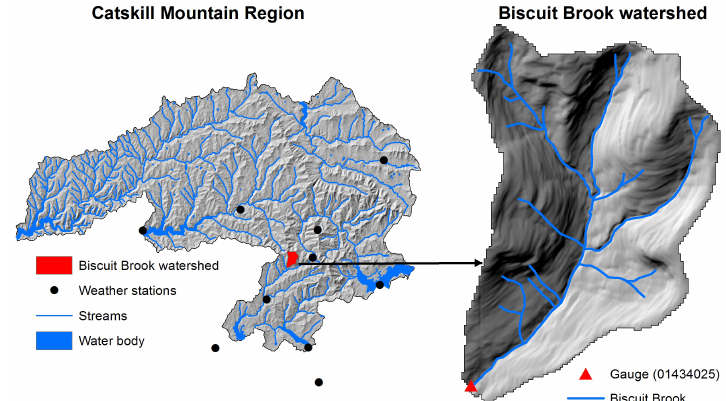
Fig. 1. The location of the Biscuit Brook watershed (red area) and the United States Geological Survey gauge station within the Catskill Mountain region of New York State. The map on the left depicts boundaries of the West of Hudson watershed and reservoirs of the New York City water supply system. The black points are 10 Cooperative Observer Program weather stations used to derive meteorological data for the